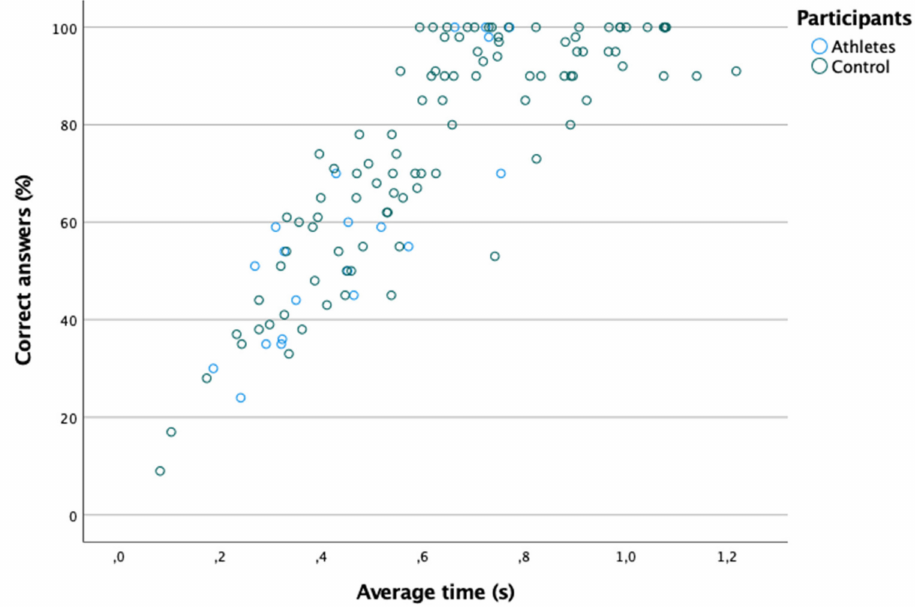
Figure 1. Positive linear relationship between the percentage of correct answers and the average time.